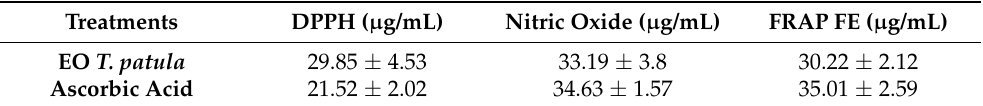
Table 2. Antioxidant activity as EC 50 ( µ g/mL) for DPPH and NO assay or FE ( µ g/mL) for FRAP assay of T . patula EO extracts (mean ± SD).